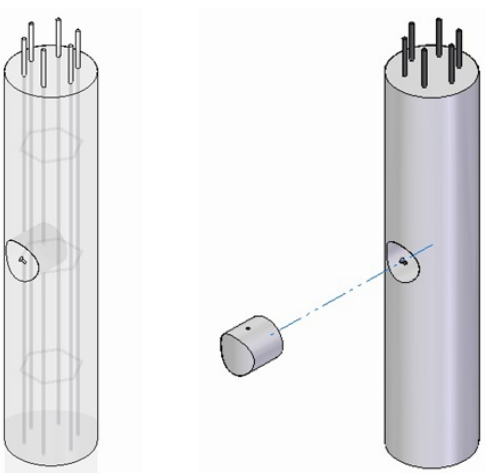
Figure 2. Extraction of core samples of cylindrical reinforced concrete specimens.